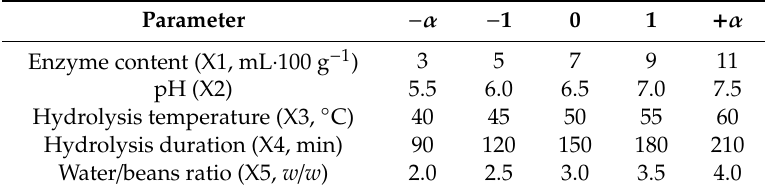
Table 3. Parameters of enzymatic hydrolysis conditions optimization using Flavourzyme. Parameter